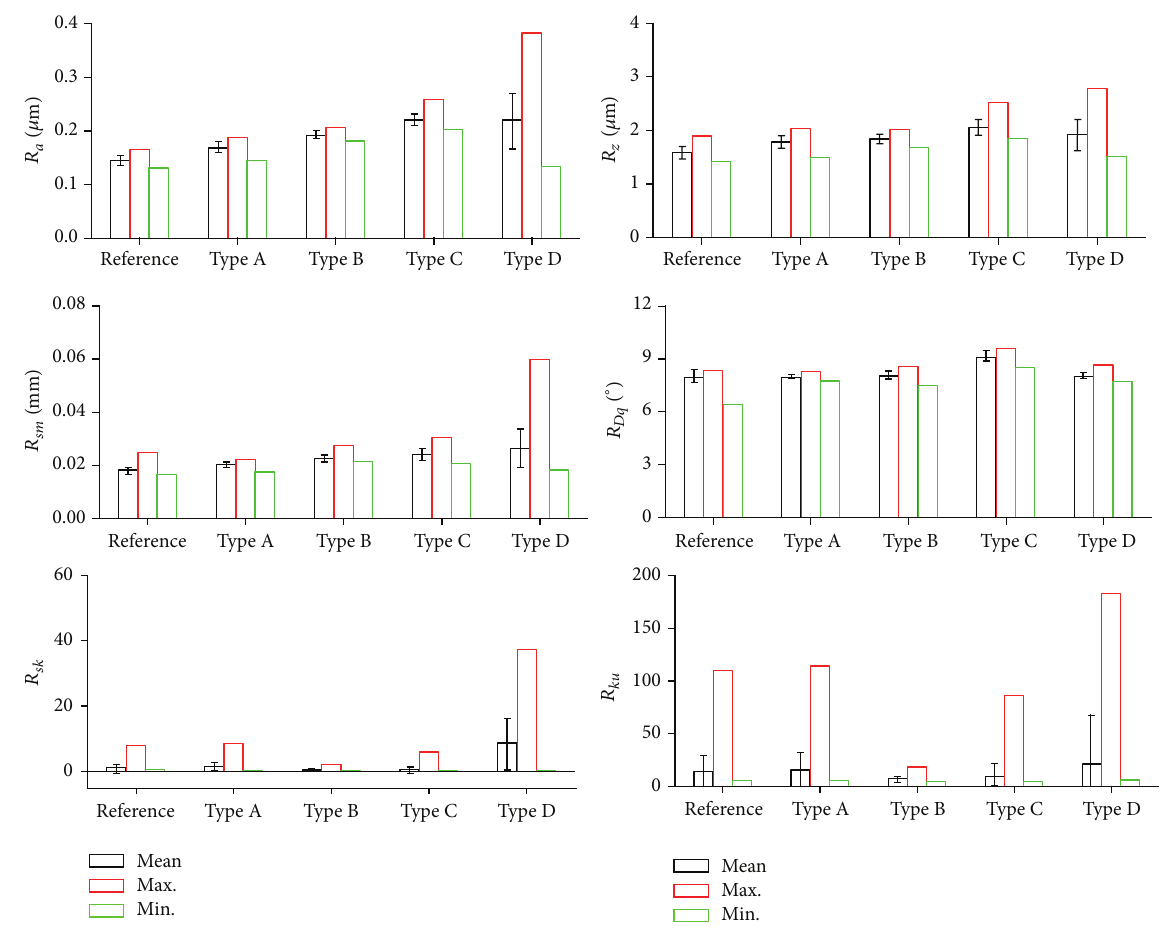
Figure 3: Roughness parameters for insulating coatings A–D and reference coating